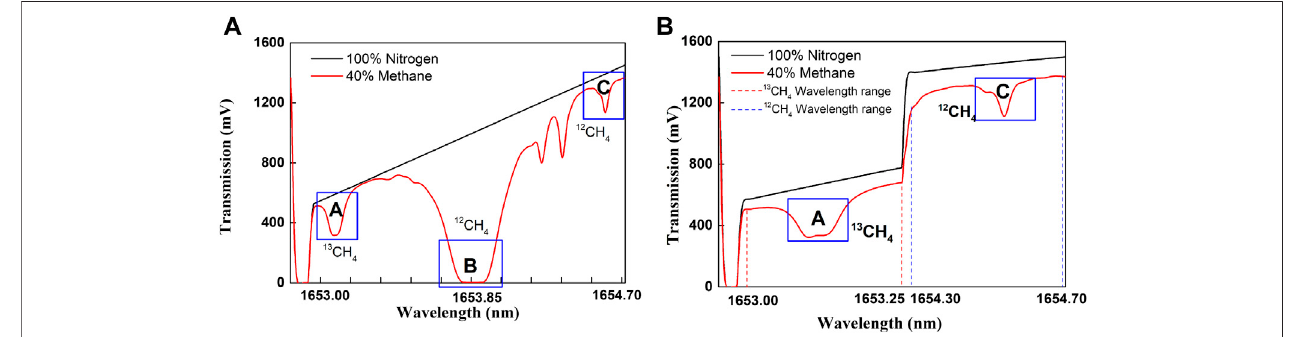
FIGURE 5 | (A) current pro fi les and transmission spectra of 40% methane in conventional one section driving (I (cid:2) 25 – 100 mA). (B) in two-section driving (I 1 (cid:2) 25 – 35 mA and I 2 (cid:2) 90 – 100 mA) scheme.